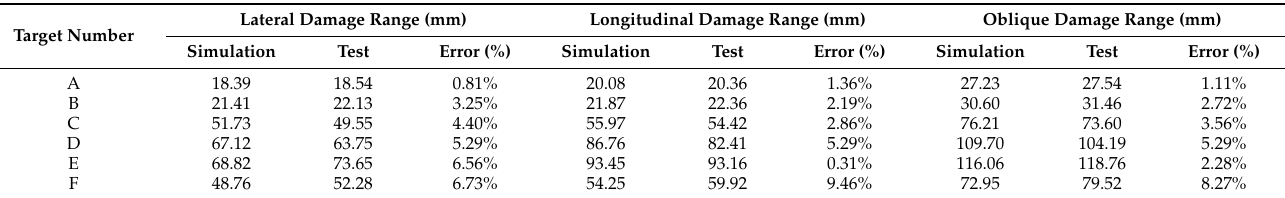
Table 5. Comparison of the lateral, longitudinal and oblique